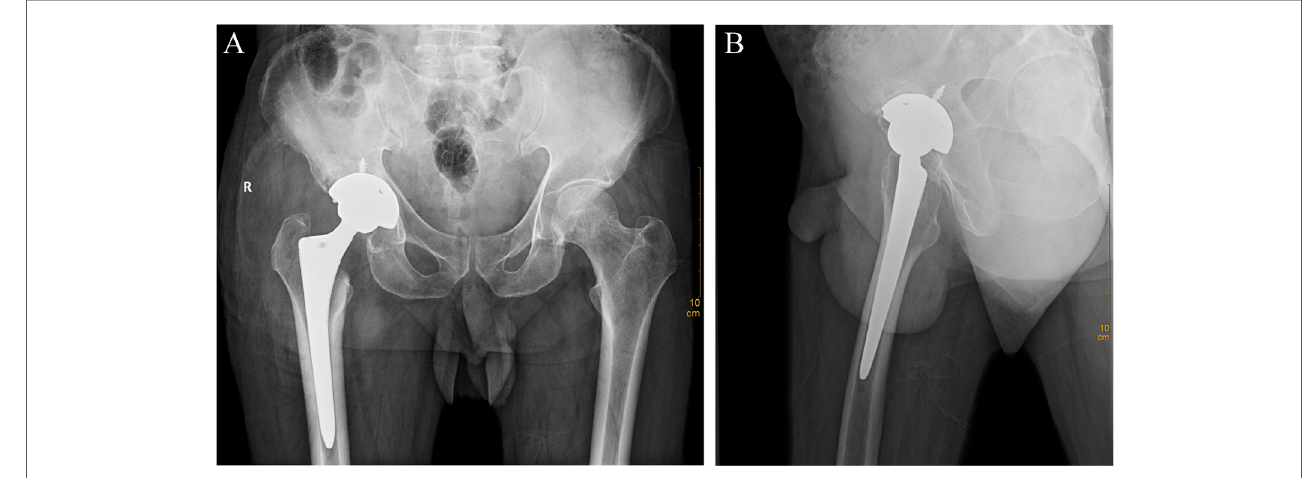
FIGURE 4 Anteroposterior ( A ) and lateral ( B ) radiographs of the hip joint 3 years after total hip arthroplasty